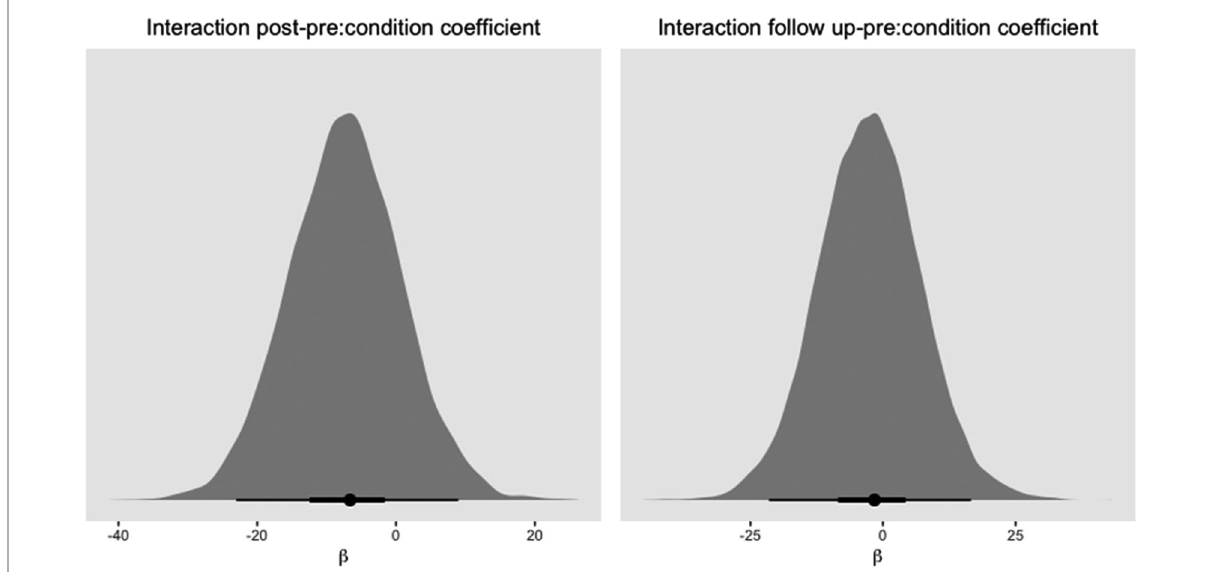
FIGURE 7 Histogram of mode of posterior distribution with 50% and 95% HDI for slopes of interaction effects predicting OQ-45-2 scores. Note that a negative β coef fi cient indicates lower OQ-45-2 scores in the 3MR